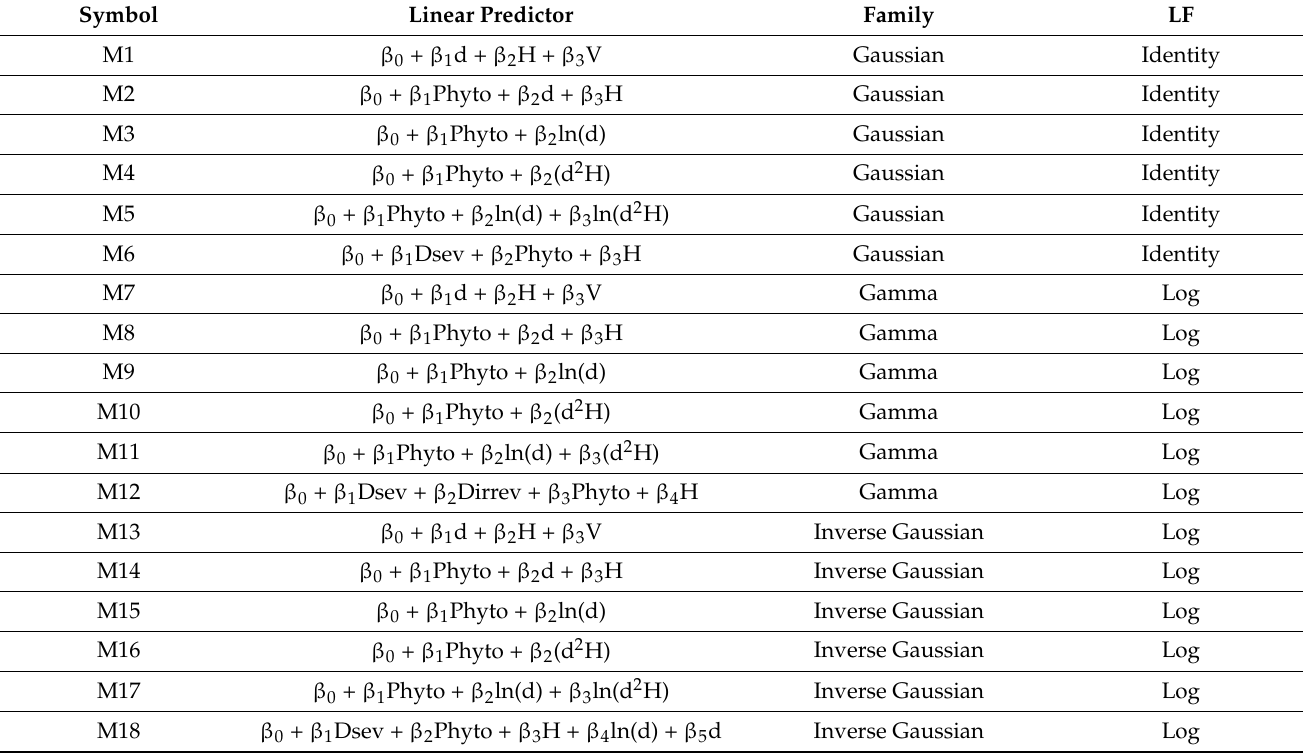
Table 3. Generalized linear models adjusted to predict the area of gap (Y = AC ) produced by the planned felling of trees in three forest phytophysiognomies of the Brazilian Amazon. Symbol Linear Predictor Family LF M1